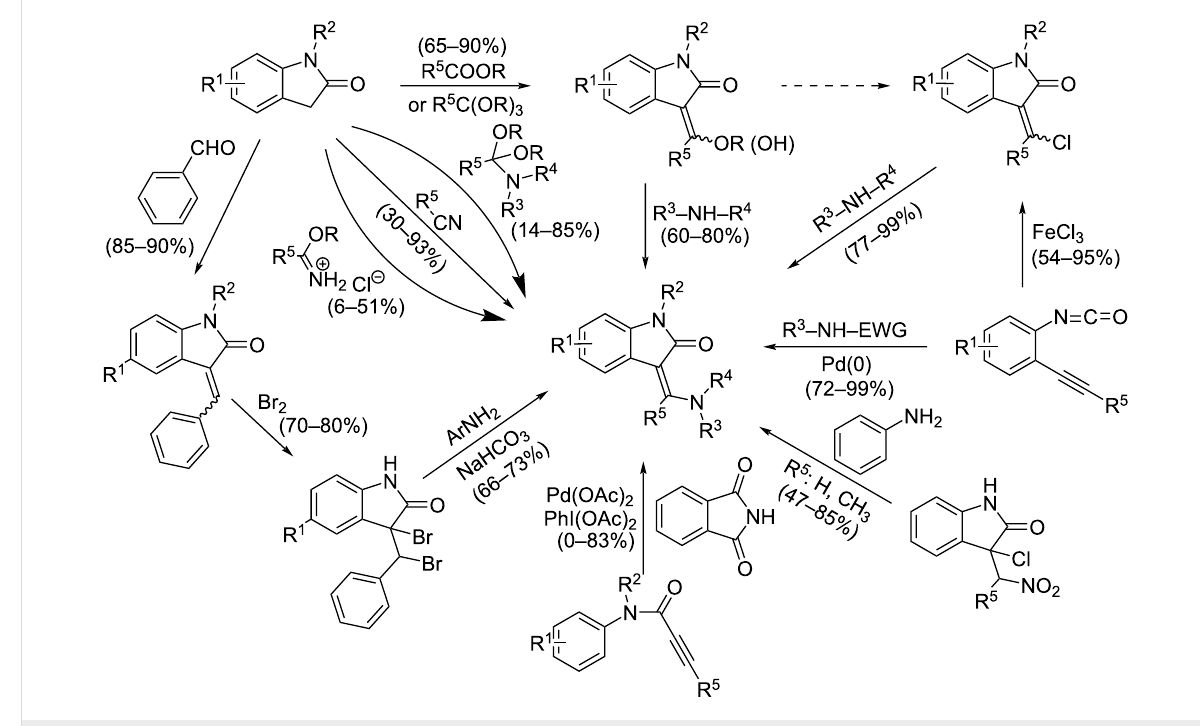
Scheme 1: The known synthetic strategies leading to 3-(aminomethylidene)oxindoles.